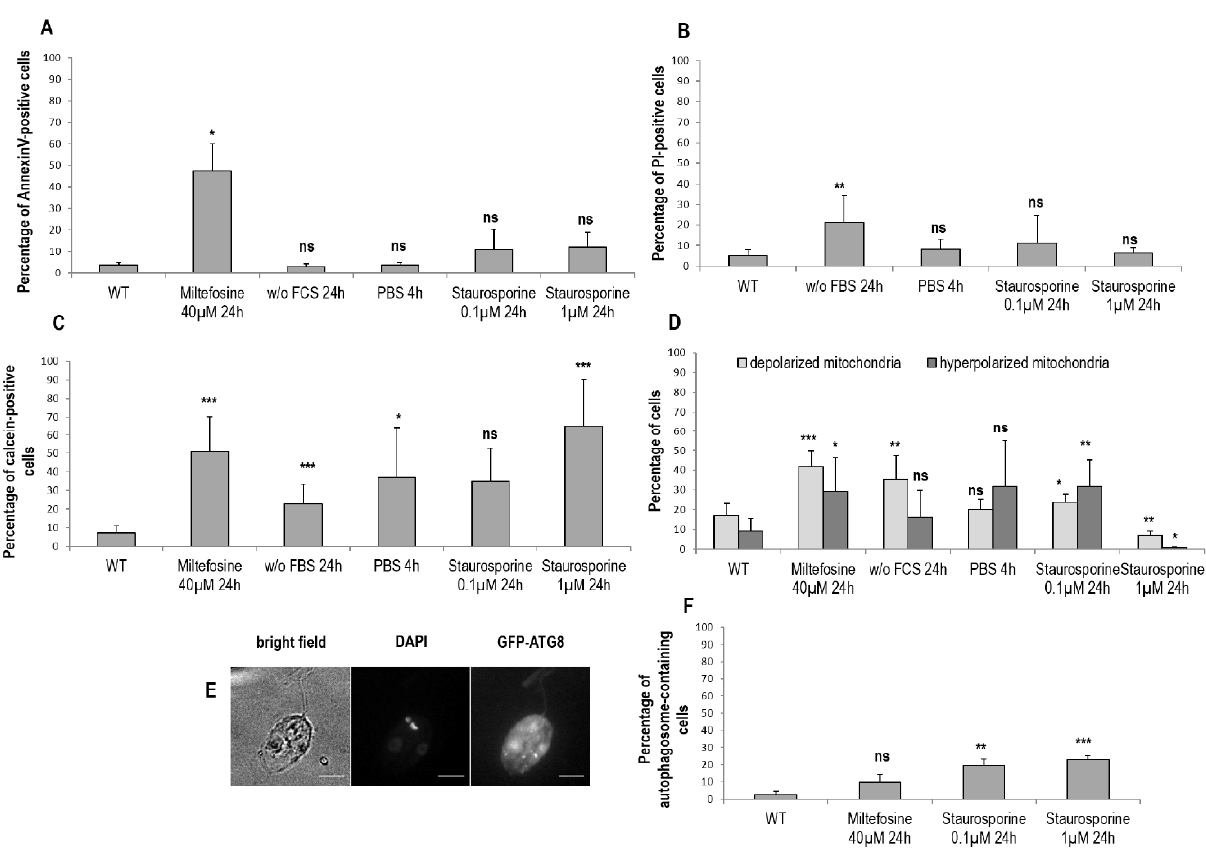
FIGURE 3: Membrane properties and autophagosome formation during Leishmania cell death and autophagy. (A) Percentage of Annexin V- positive cells in different culture conditions (≥ three independent experiments). (B) Percentage of PI-positive cells in different culture condi- tions (≥ three independent experiments). (C) Percentage of calcein-positive cells in different culture conditions (≥ three independent experi- ments). (D) Percentage of cells with a depolarized or hyperpolarized mitochondrion in different culture conditions determined by DIOC 6 stain- ing (≥ three independent experiments). (E) Microscopical observation of cells transfected with GFP-ATG8 and treated for 24 h with 0.1 µM of staurosporine (bar = 5 µm). The GFP-ATG8 puncta are indicative of autophagosomes. (F) Percentage of autophagosome-containing cells after treatment for 24 h with miltefosine and with staurosporine or not (WT). A minimum of 722 cells were counted, from three independent experiments. Unpaired t-test: ns not significant, * p < 0.05, ** p < 0.01, *** p <